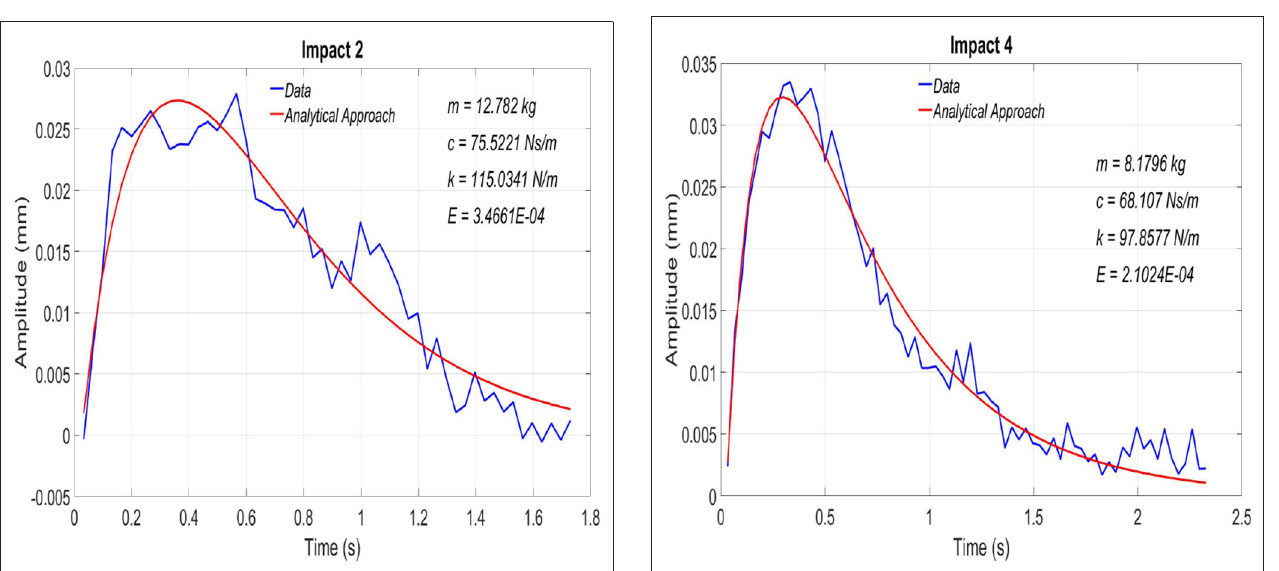
FIGURE 7 | Test 4, Optical characterization (blue) and Analytical results (red).